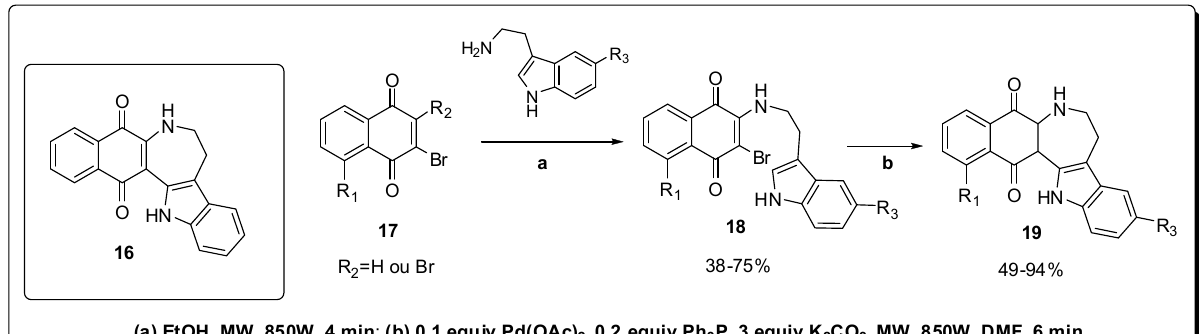
Figure 6. Synthesis of azepinonaphthoquinones with anti-inflammatory activity.